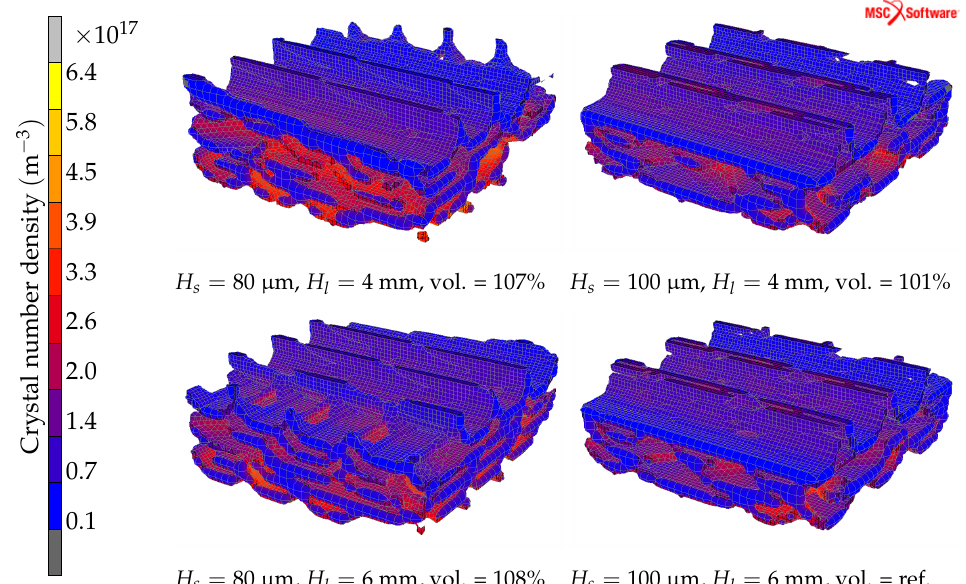
Figure 7. Finite elements in the control volume with a crystalline volume fraction ≥ 10%. Colour contour shows the crystal number density (m − 3 ), H s — hatch spacing, H l —hatch length, vol. are the relative size of this quantity with respect to the reference with the least element volume.